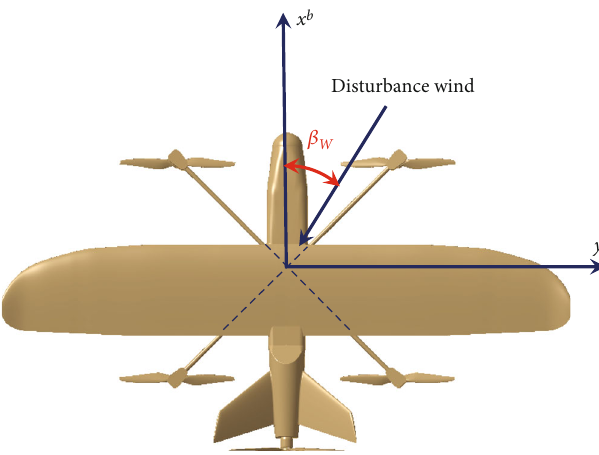
Figure 22: The velocity and direction of the wind